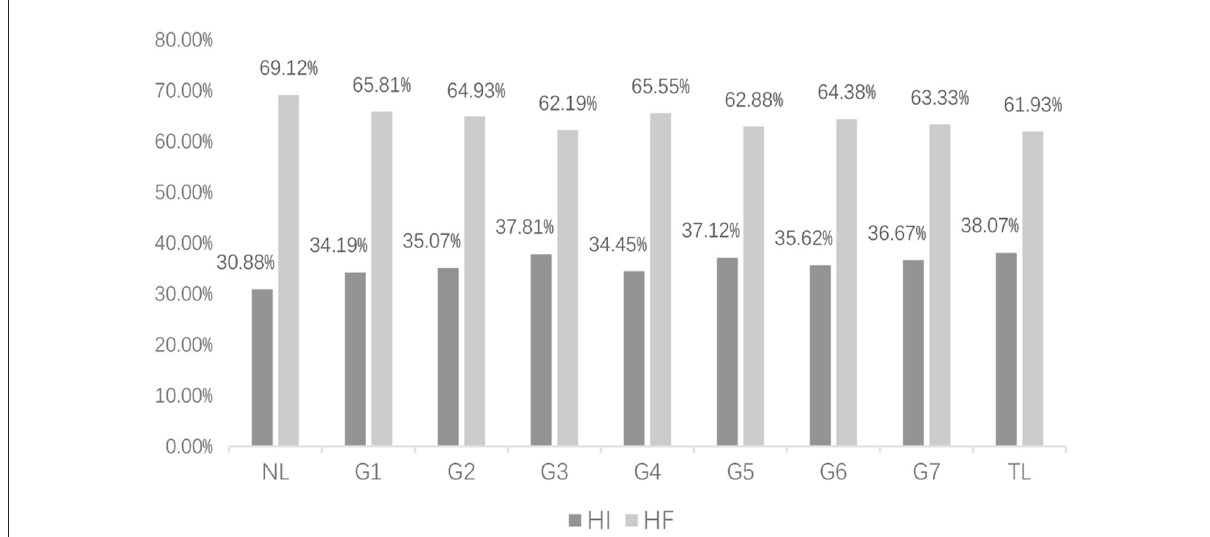
FIGURE3 In spoken modality, distribution of ECSL learners’ dependency directions at each level and in the contrastive treebanks.